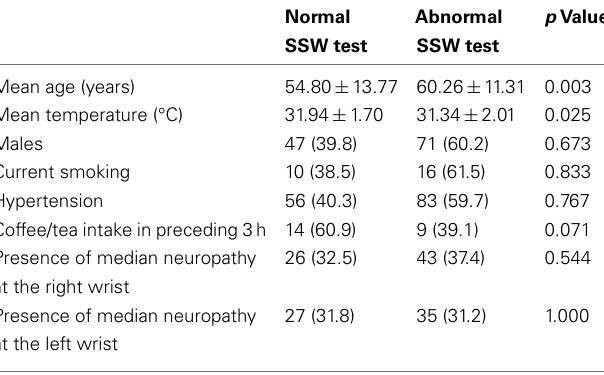
Table 2 |Variables associated with SSW